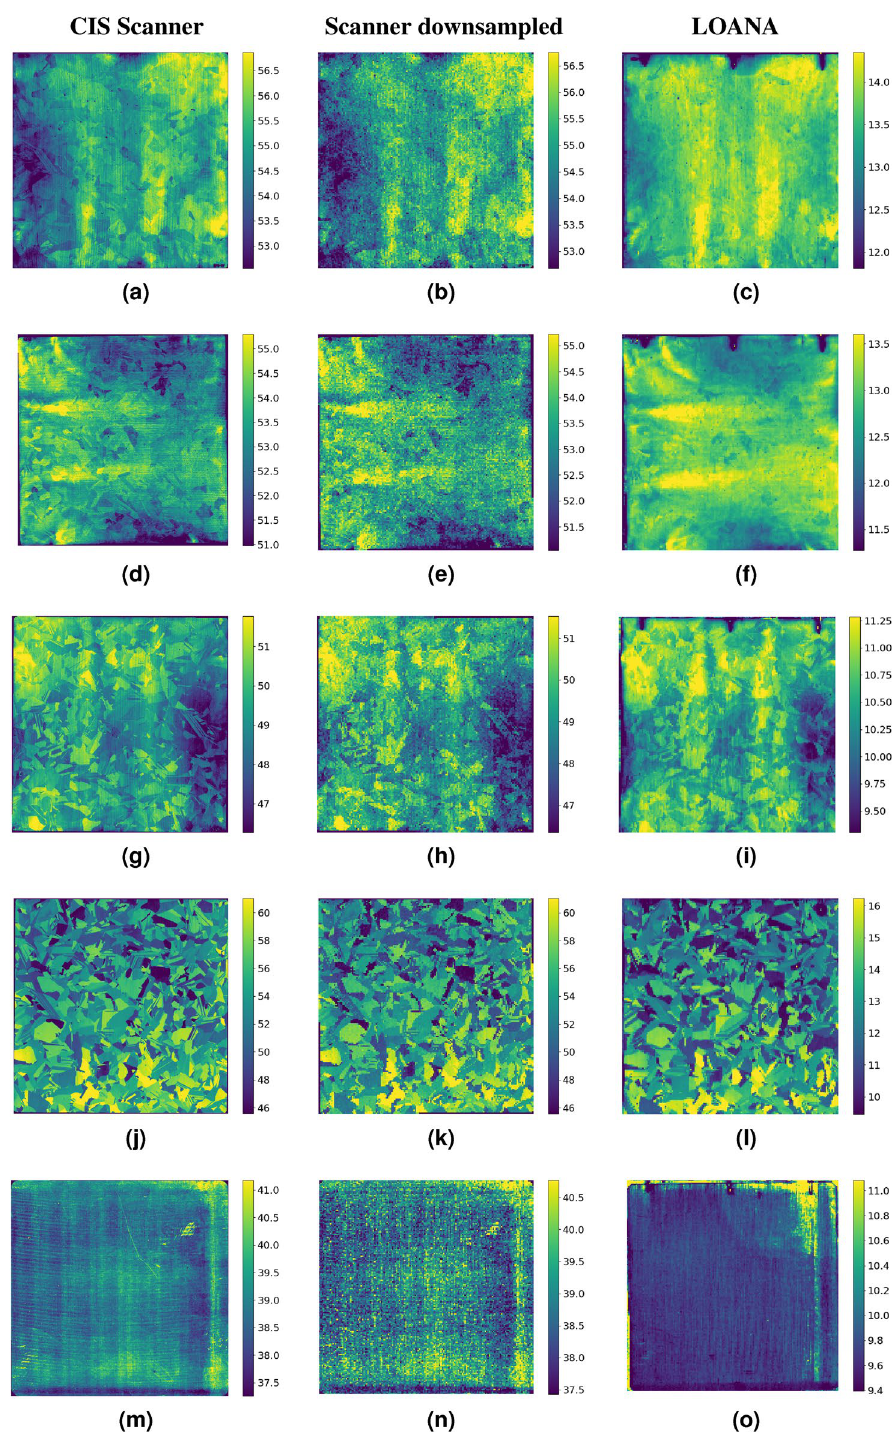
Figure 3. Comparison of the blue channel of scans on a CIS based scanner of four multi-crystalline wafers ( a – i ) and one mono-crystalline wafer ( m – o ) taken with the CIS scanner and a hemispherical reflection map at 405 nm taken with the LOANA. The images going from left to right in each row are acquired with the scanner, the scanner but downsampled to the resolution measured by the LOANA, and finally, the LOANA. The samples shown in this figure are in each row, with the first row showing Multi-1, followed by Multi-2, Multi-3, Multi-4 and finally